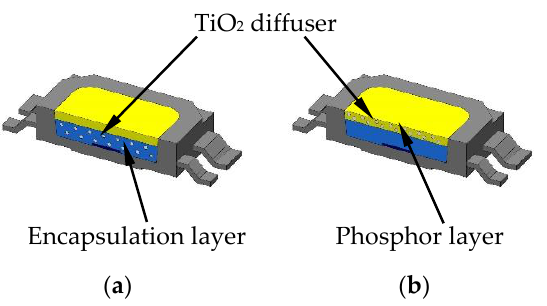
Figure 2. Schematic diagrams of the TiO 2 diffuser in the ( a ) encapsulation layer and ( b ) phosphor layer of the remote phosphor LEDs.